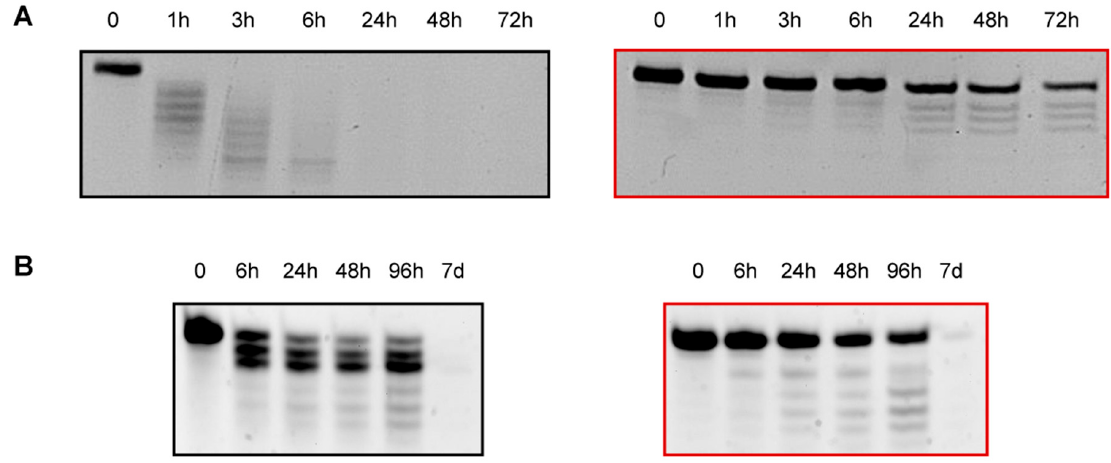
Figure 5. Stability of unmodified and modified ssRNAs against 3 ′ - and 5 ′ - exonucleases ( A ) SVPD degradation of native ( AS1 ) (left panel) and 3 ′ -end modified ( AS2 ) (right panel) single stranded RNAs; ( B ) BSP degradation of native ( SS1 ) (left panel) and position 2 modified ( SS4 ) (right panel) single stranded RNAs. For experimental conditions see Material and